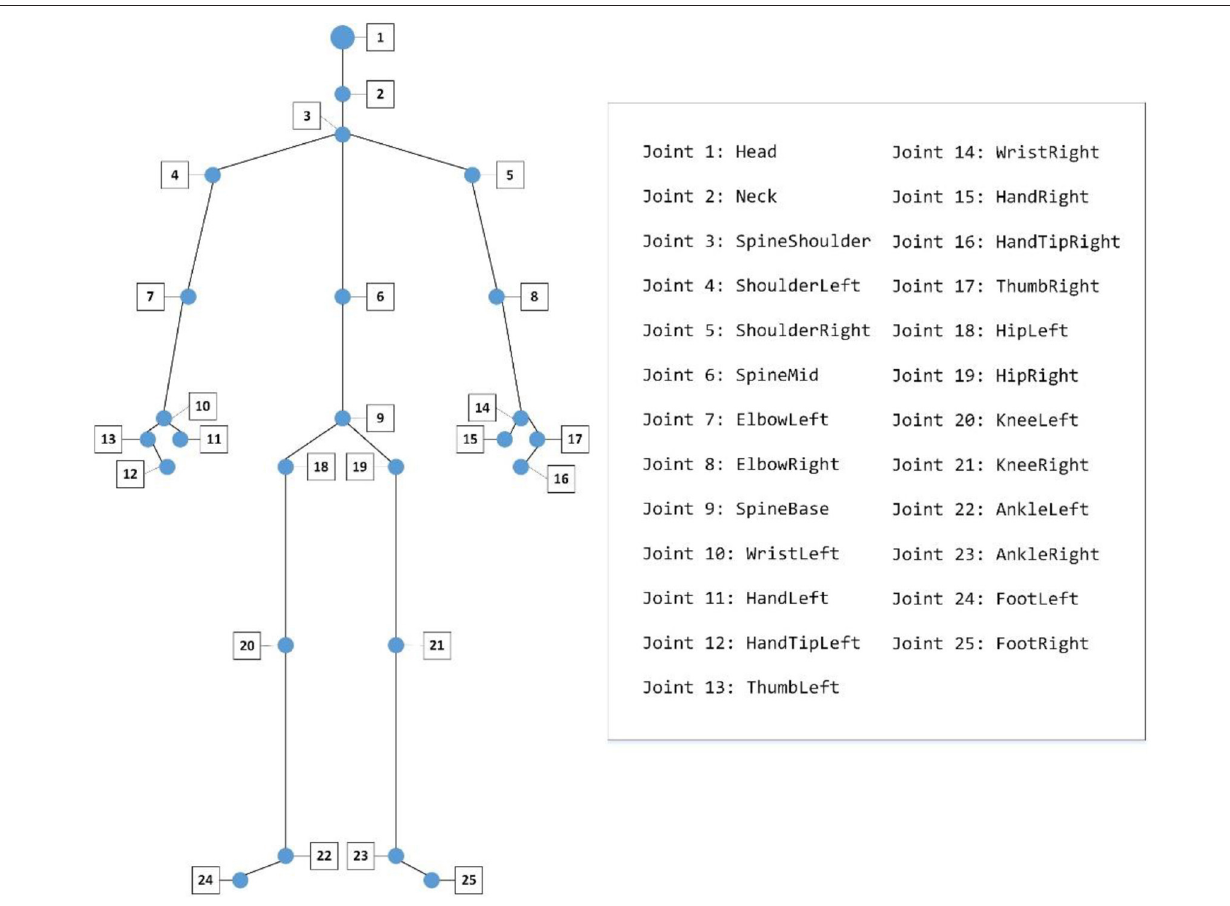
Frontiers in Psychiatry |